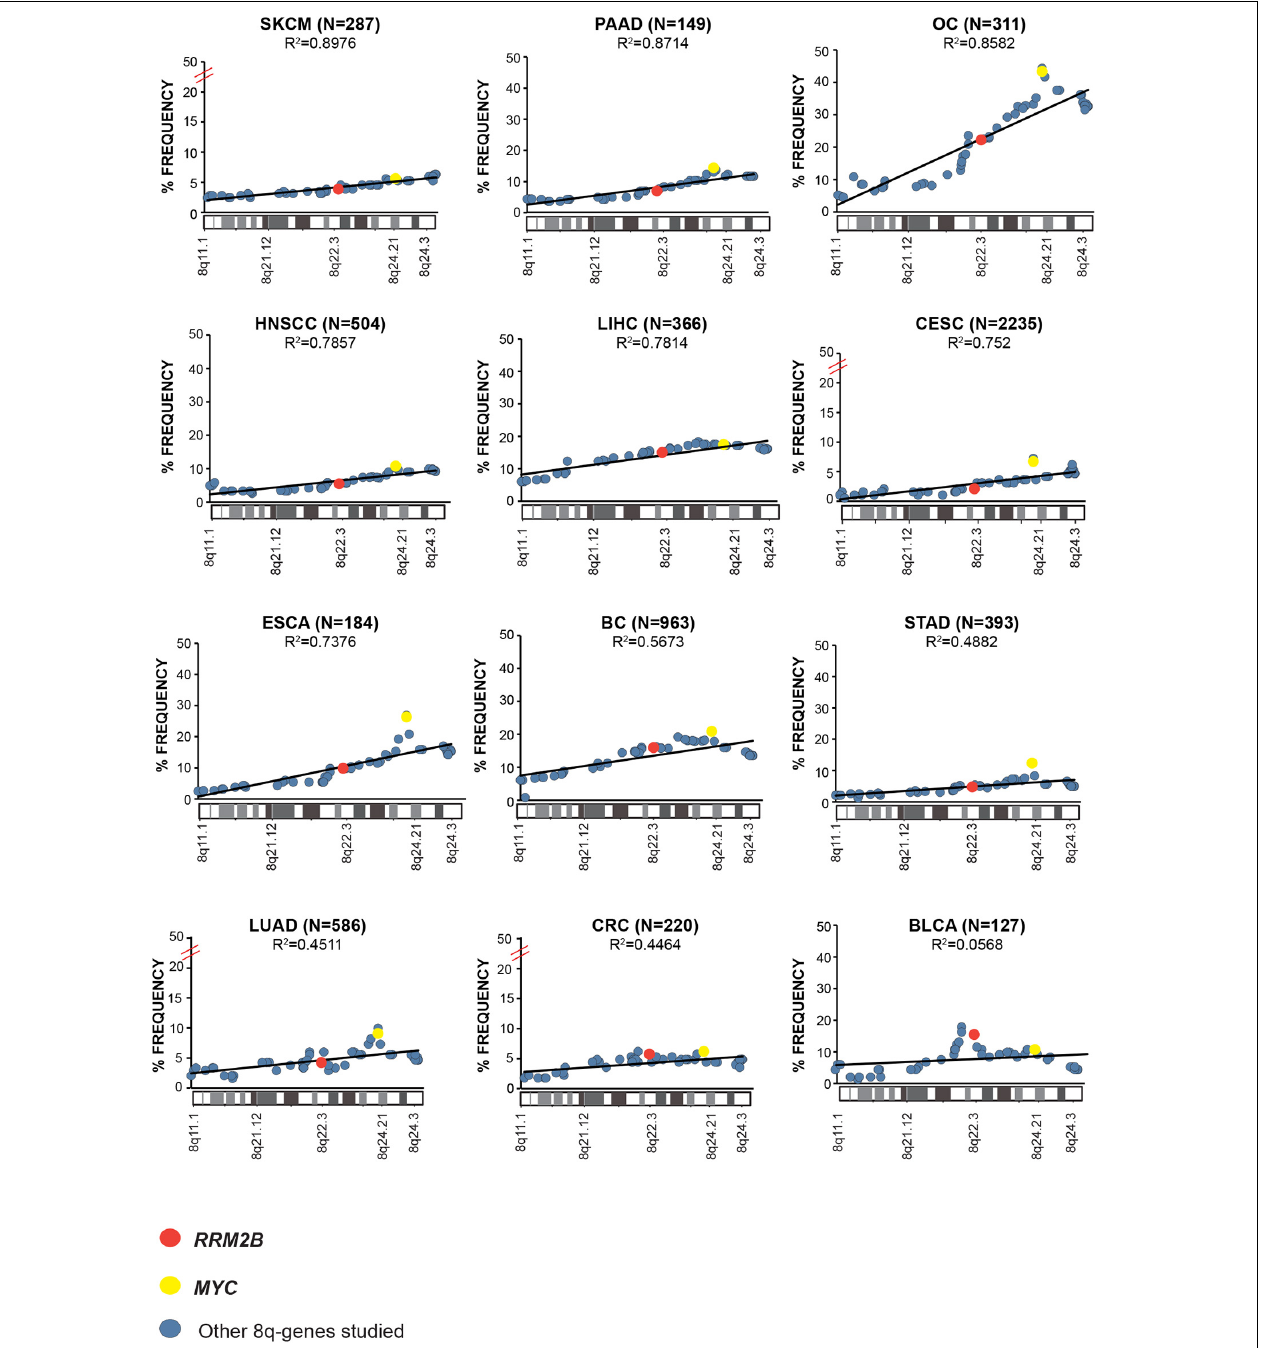
FIGURE 3 | Amplification frequency of cancer relevant 8q-genes in SKCM, Skin cutaneous melanoma; PAAD, Pancreatic adenocarcinoma; OC, Ovarian serous cystadenocarcinoma; HNSCC, Head and neck squamous cell carcinoma; LIHC, Liver hepatocellular carcinoma; CESC, Cervical and endocervical cancers; ESCA, Esophageal carcinoma; BC, Breast invasive carcinoma; STAD, Stomach adenocarcinoma; LUAD, Lung adenocarcinoma; COAD, Colon adenocarcinoma; BLCA, Bladder urothelial carcinoma, amplifications were plotted as percent of frequency for amplifications. RRM2B (red circle), MYC (yellow circle), and other genes (blue circle). The Pearson correlation ( R 2 value) for the data points is represented by a black trend line.